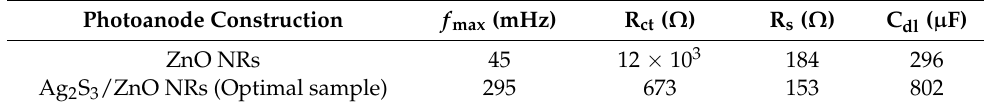
Table 3. Impedance spectroscopy analysis of photoanodes.